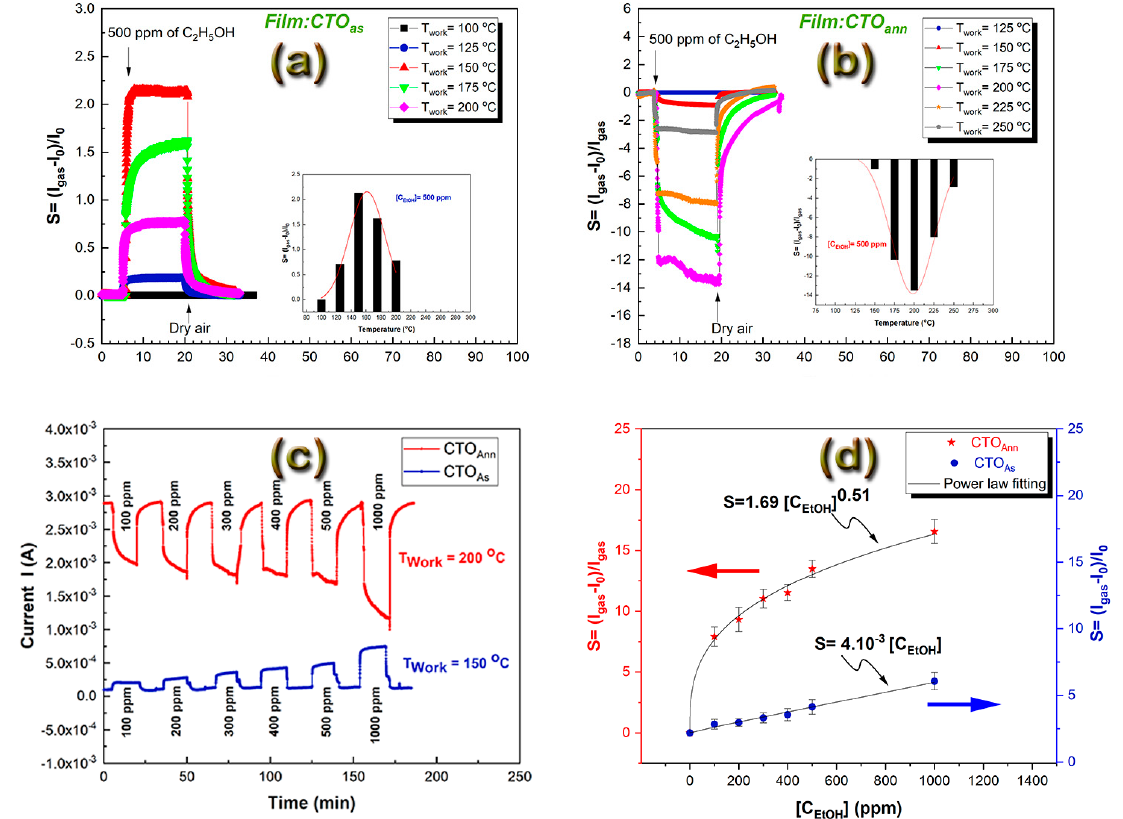
Figure 5. CTO as and CTO ann ethanol sensing results: ( a ) optimal working temperature determination of as-prepared film (CTO As ) under 500 ppm of ethanol; ( b ) optimal working temperature determination of annealed film (CTO Ann ) under 500 ppm of ethanol; ( c ) dynamic current variation of prepared layers at optimum temperatures; ( d ) layers’ response evolutions versus ethanol concen- tration.